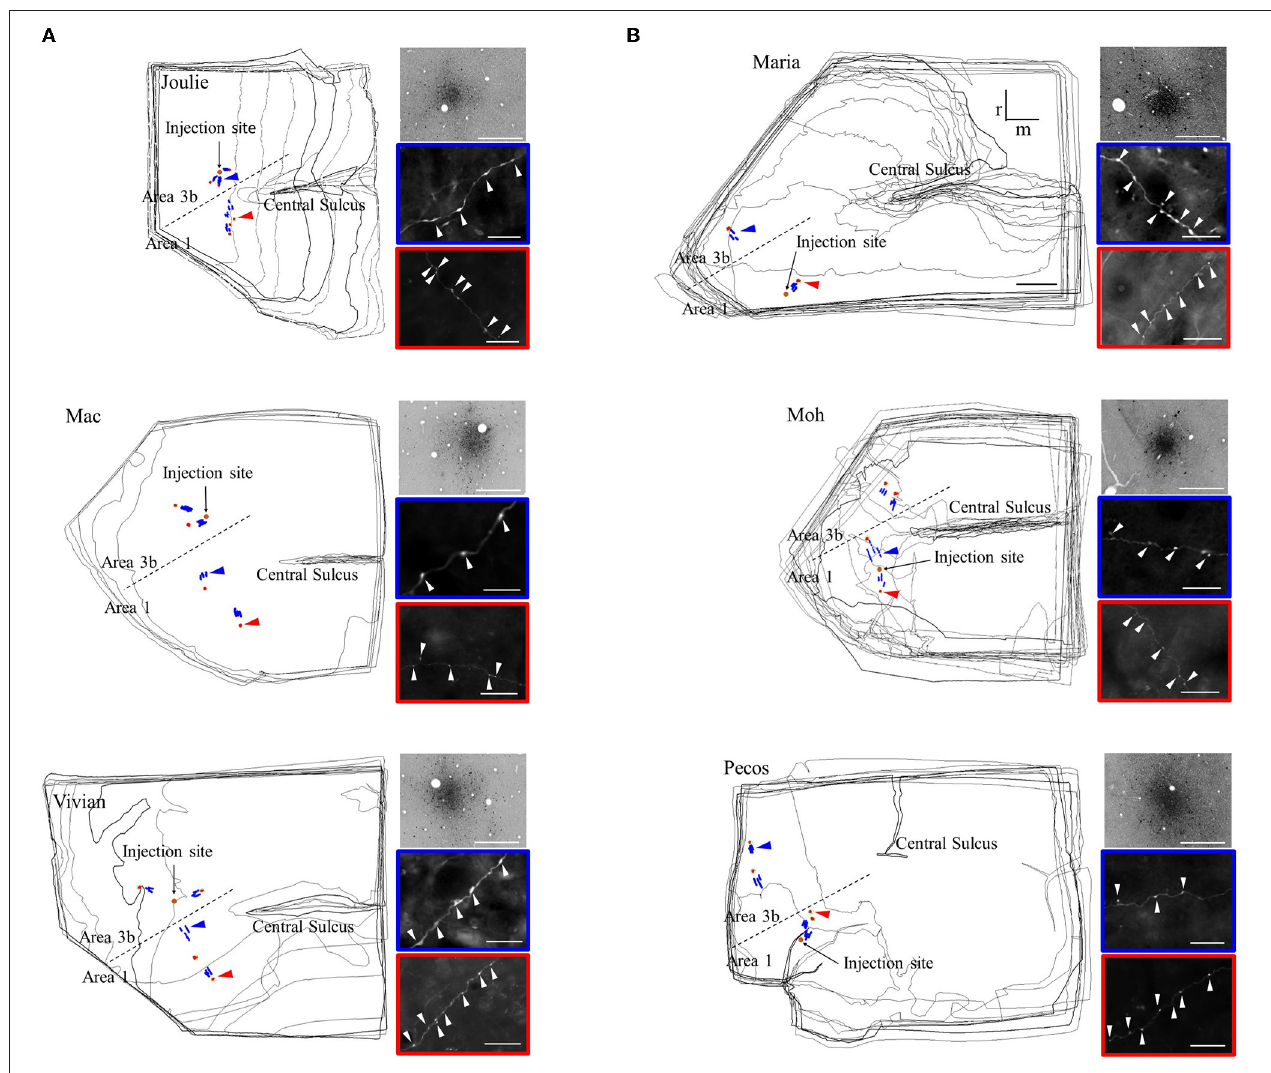
FIGURE 1 | Distribution (left drawings) and light microscopic appearance (right panels) of the reconstructed long-distance axonal segments. (A) Area 3b injections and (B) area 1 injections. Distribution of the reconstructed axons is shown on the merged series of sections in the six cases. Anterograde labeling is represented by patch-forming axons (red) and no-patch-forming axons (blue) in the hand representation region of areas 3b and 1. The name of cases is indicated in the upper left corner. CS: central sulcus, dashed line: border between areas 3b and 1. Orange circle show the injection site located in the representation of a distal finger pad. The orientation bars on B (case M) apply to all panels; r: rostral, m: medial. Scale bar on B (case M) represents 1mm, applies also to the other cases. Right panels: light microscopic images enclosed by a color border are taken from the sites indicated by the arrowheads of the same color on the drawings. Top panels show the injection site. Middle and lower panels show, respectively, no-patch axons and patch-forming axonal segments with numerous boutons in the form of varicosities (white arrowheads). Scale bar: 25 µ m (right, top), 20 µ m (right, middle and